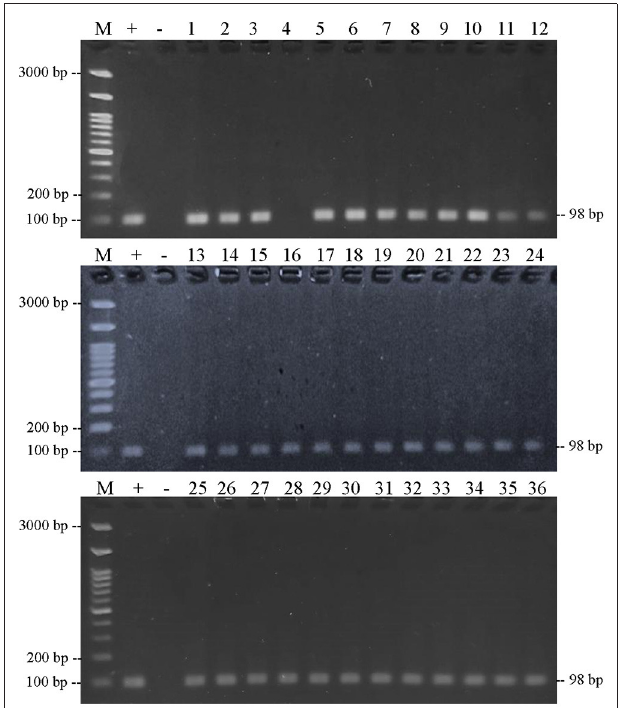
FIGURE 5 | Results of PCR amplification of meatball samples in Bojonegoro Regency with bovine primers electrophoresed on a 2% agarose gel. (M) DNA marker 100 bp; ( + ) positive control meatballs; (–) negative control (no template control); samples were coded with numbers N1–N36.